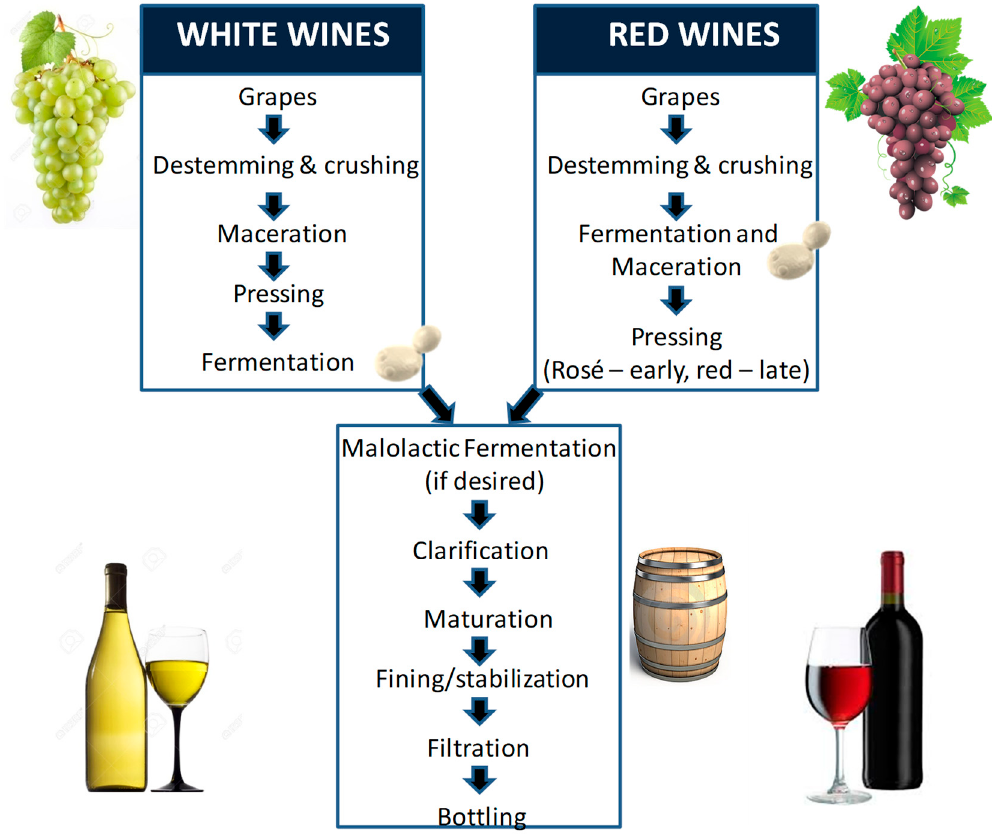
Figure 1. An example of a winemaking process for white and red wines. In this case maceration was included in the white winemaking process, this is optional, and not a common practice.